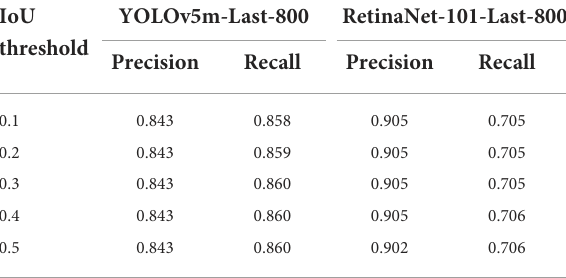
TABLE 5 The precision and recall scores when changing the IoU confidence threshold from 0.1 to 0.5 and the confidence score is always 0.5.